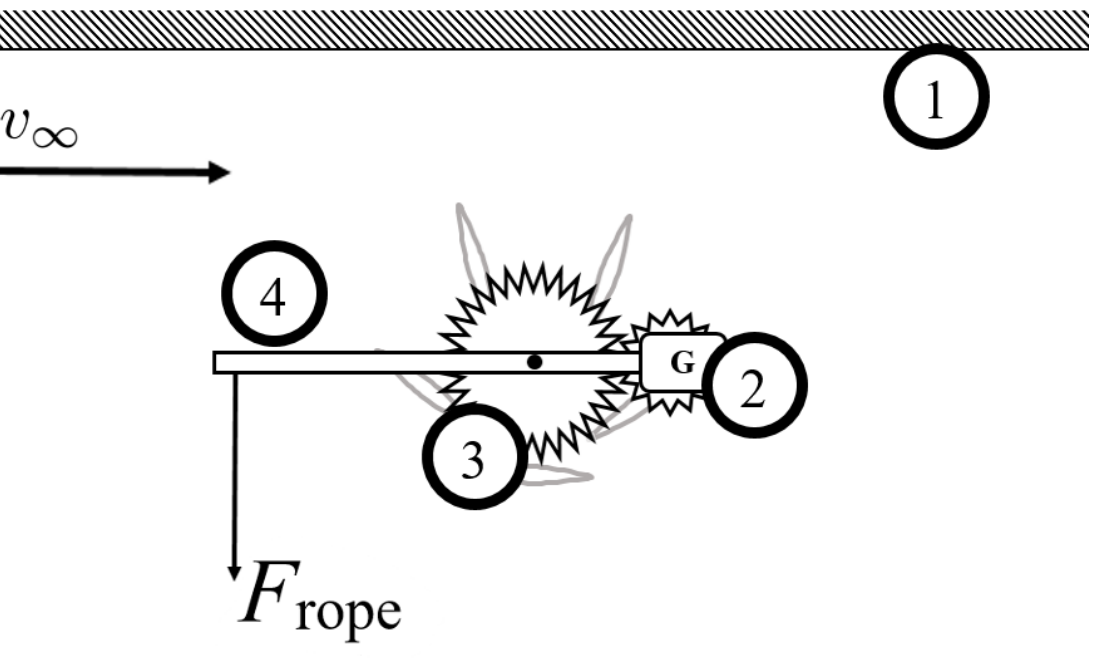
Figure 3. Functional sketch of the measuring setup: (1) duct wall; (2) generator with pinion; (3) turbine with main gear; and (4) free-floating